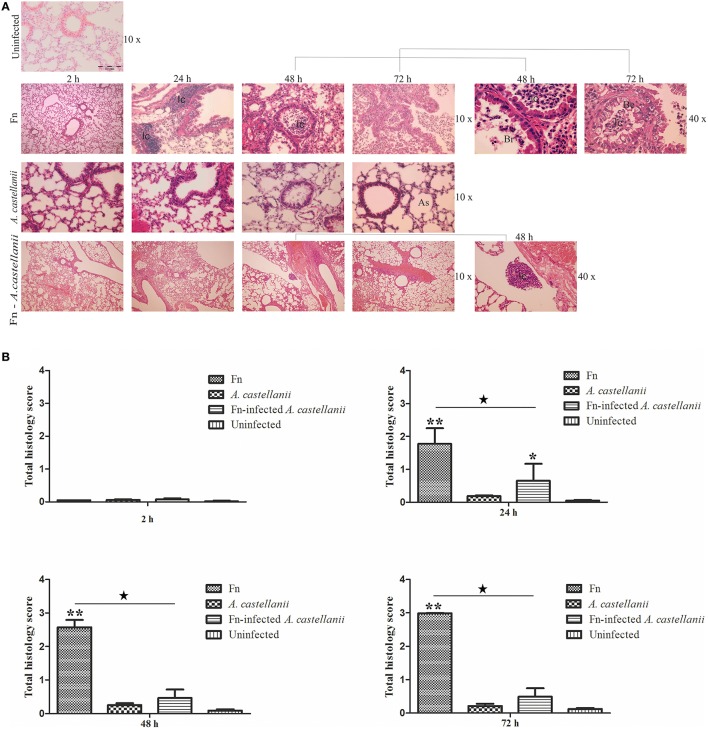
Lung histopathology of Balb/c mice inoculated i.t. with F. novicida, A. castellanii and/or F. novicida-infected A. castellanii. (A) At 2, 24, 48, and 72 h after infection of Balb/c, pulmonary tissue sections were stained with H&E (Hematoxylin and eosin stain). The experiments were done in triplicate using three mice for each time point, and the images are representative of 20 microscopic fields from each animal. Uninfected mice were used as negative control. The results are representative of three independent experiments. As-alveolar spaces, Br-bronchioles, Be-bronchial epithelium, Ic-inflammatory cells. (B) Twenty random high-powered fields (HPFs) were assessed to grade inflammation severity including alveolar and bronchial damage as well as percentage of parenchyma involved. The histology assessment included the number of the mononuclear cells and percent of parenchyma involved by using modification of double-blind scoring method at a magnification of 40x, as described previously (De Simone et al., 2014). The inflammation process was graded normal (score of 0) when there were 0–19 monocular cells infiltrates per HPF with no alveolar and bronchial involvement, mild (score of 1) for 20–49 cells per HPF including mild damage of alveolar and bronchial regions, moderate (score of 2) for 50–99 cells per HPF with moderate alveolar and bronchial inflammation, or severe (score of 3) for 100–200 mononuclear cells per HPF with severe effacement of alveolar and bronchial regions. The murine lung section was examined in sagittal direction and percent of parenchyma involved was scored as 0 when no area was compromised. The involvement of the parenchyma was scored as 1 when up to 25% of the total area was occupied by inflammatory exudate; was scored as 2 when 26 to 50% of parenchyma area was occupied with inflammatory cells, 3 if comprised more than 51%. The total histology score was calculated as an average of individual criteria scores. The uninfected tissue was used as a baseline score, *P < 0.05 and **P < 0.001. In addition, statistically significant differences between F. novicida and F. novicida-infected A. castellanii groups are marked by ⋆p < 0.05. The bar represents the median score in each group.